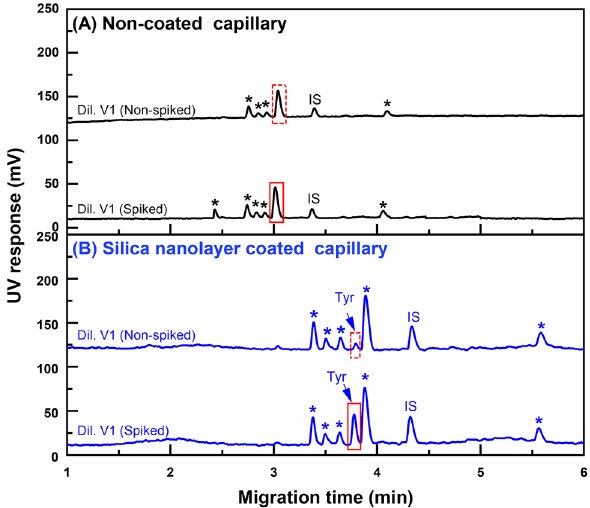
Figure 5. Electropherograms obtained from using two capillaries; ( A ) Non-coated capillary and ( B ) Coated silica nanolayer. The sample was analyzed using 20-fold diluted balsamic vinegar V1, sample spiked with standard tyramine at 50 μg L -1 . The CEC conditions are: phosphate running buffer (20.0 mM, pH 2.5), 38.0 cm effective column length, 60.0 cm total column length, separation field strength of 400 V cm -1 (24 kV applied), electrokinetic injection for 3 s at 400 V cm -1 , and absorbance measurement at 200 nm. Peak identification: Tyr (tyramine), IS (benzhydrylamine), * (unidentified peaks).